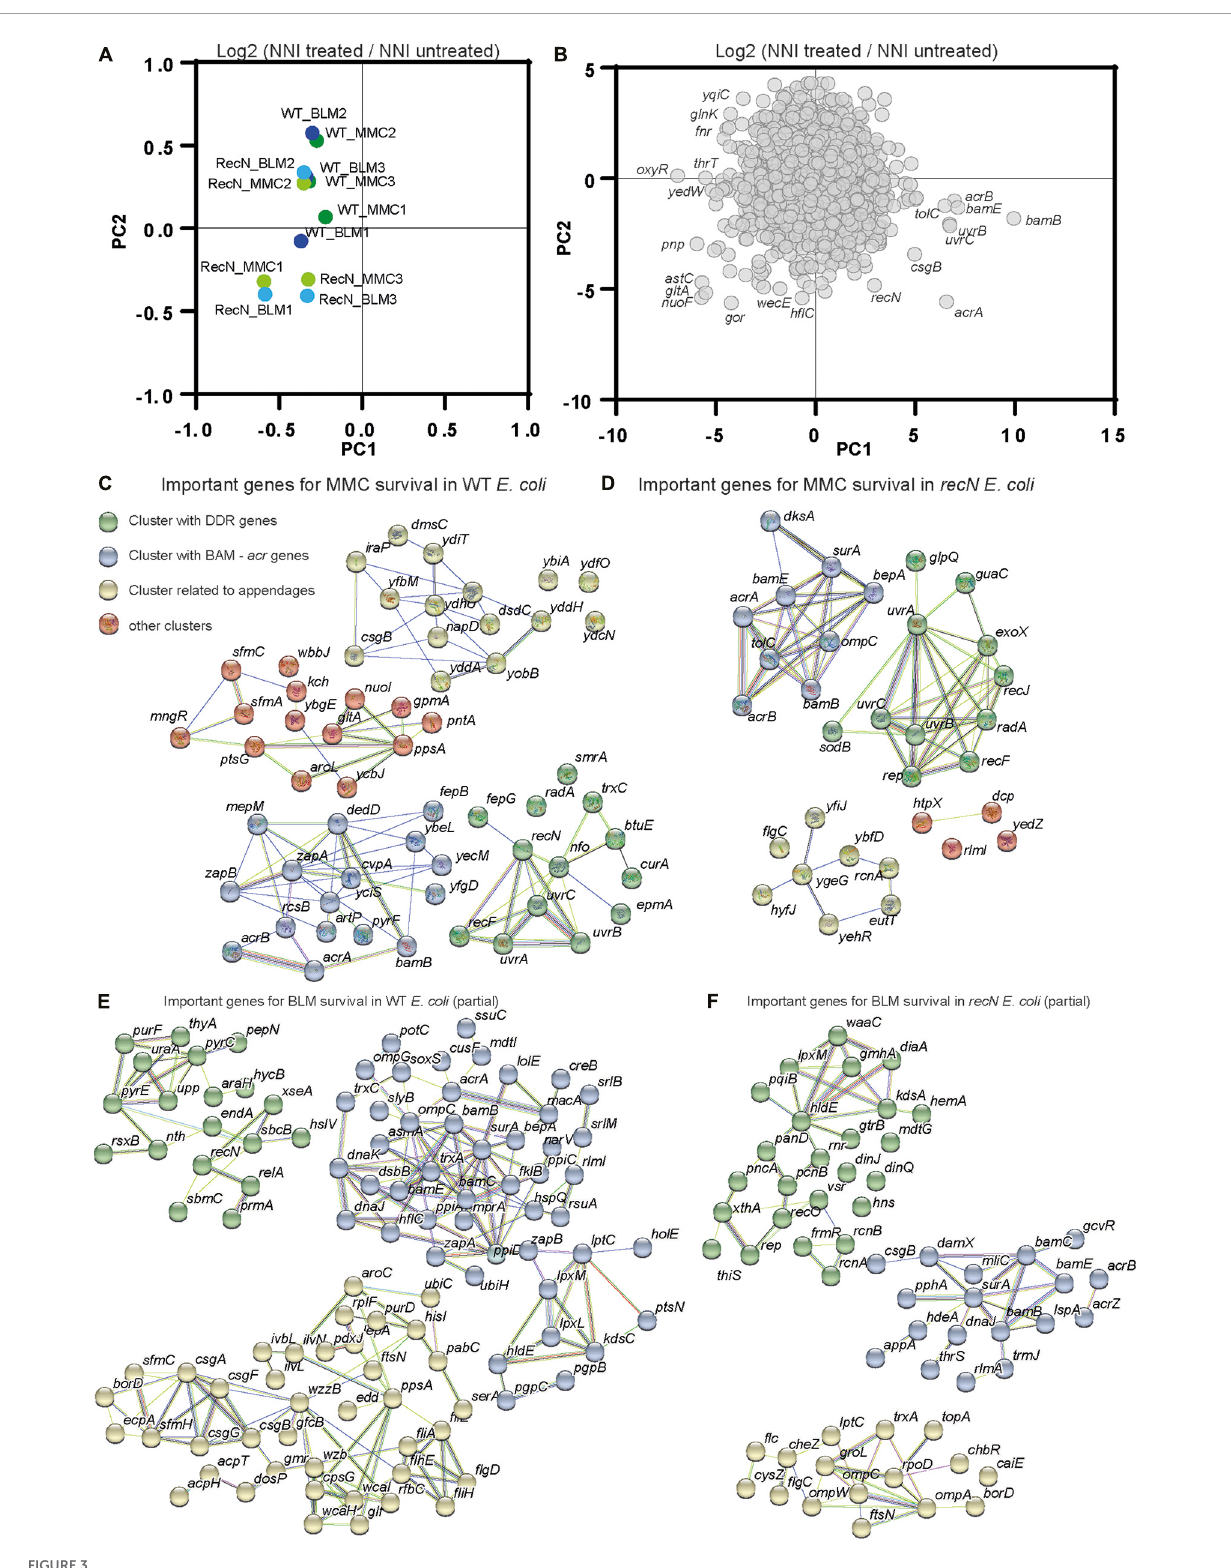
FIGURE3 Transposon-insertion sequencing (TIS) analysis of the GSR associated with BLM and MMC tolerance. (A) Principal component analysis of TIS data. Fold changes (Log2 NNI treated/NNI untreated) were used to cluster conditions and replicates. (B) Principal component analysis of TIS data. TIS fold change in the different conditions and replicates was used to cluster genes. (C) Functional Kmeans clustering (https://string-db.org, medium confidence score) of important genes (Log2 FC MMC − wt < –2, P -value < 0.1) for MMC survival in WT E. coli . (D) Functional Kmeans clustering of important genes for MMC survival in the recN strain. (E) Functional Kmeans clustering of important genes for BLM survival in WT E. coli . Only a portion of the genes was represented (63/123), the full list is available on Supplementary Table 1 . (F) Functional Kmeans clustering of important genes for BLM survival in the recN strain. Only a portion of the genes was represented